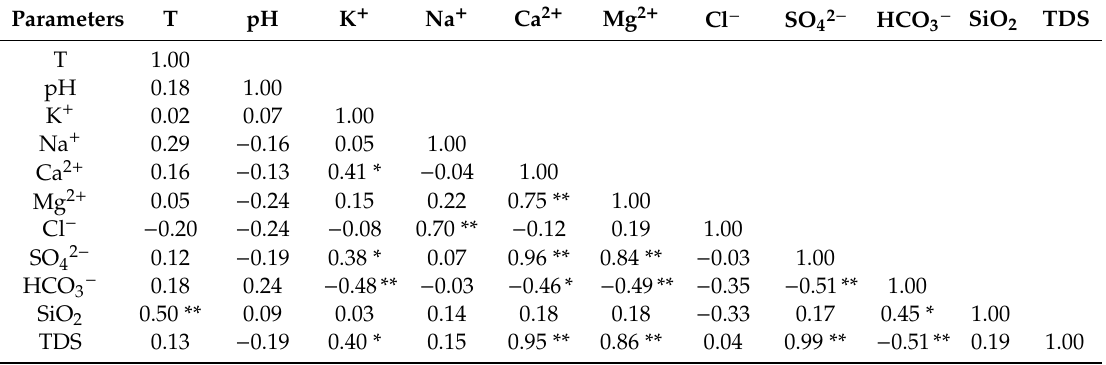
Table 2. Correlation coe ffi cient matrix among the physico-chemical variables of the thermal groundwater.